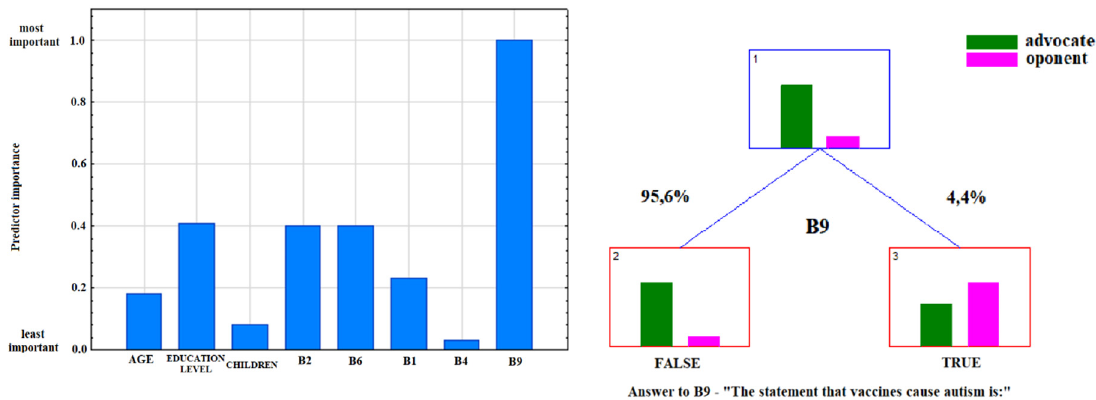
Figure 6. Ranking of predictors and decision tree for answer to the question B8: “Do you consider yourself an advocate or opponent of vaccination?” including question B9.